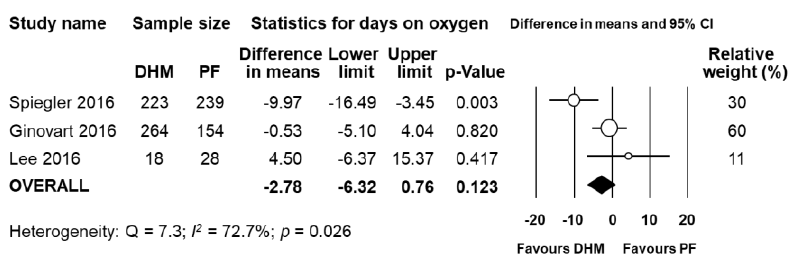
Figure 6. Meta-analysis of observational studies assessing the effects of supplementation of MOM with DHM, compared with supplementation with PF, on mean days on oxygen. Circles (O) represent the effect sizes per study, and their size represents the relative weight of the study in the meta-analysis. Diamonds ( ◆ ) represent the pooled effect size. DHM: donor human milk; PF: preterm formula.